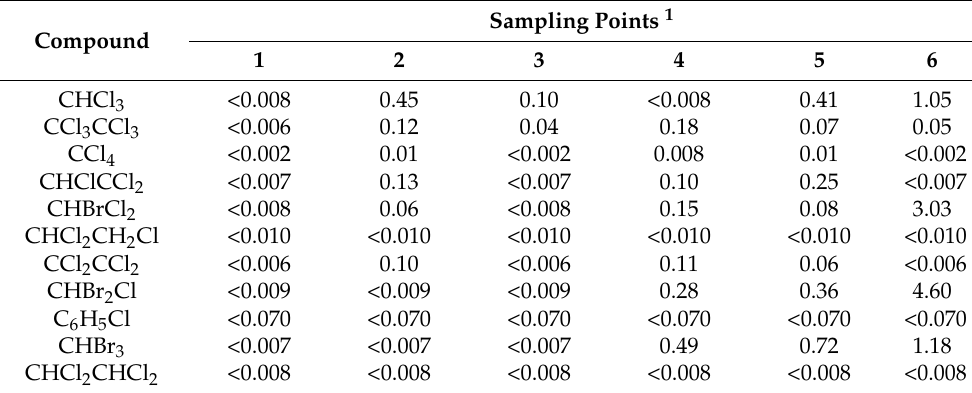
Table 5. Organohalogen levels ( µ g L − 1 ) determined at different points of Rome’s water supply. Sampling Points 1 Compound 1 2 3 4 5 6 CHCl 3 <0.008 0.45 0.10 <0.008 0.41 <0.006 0.12 0.04 0.18